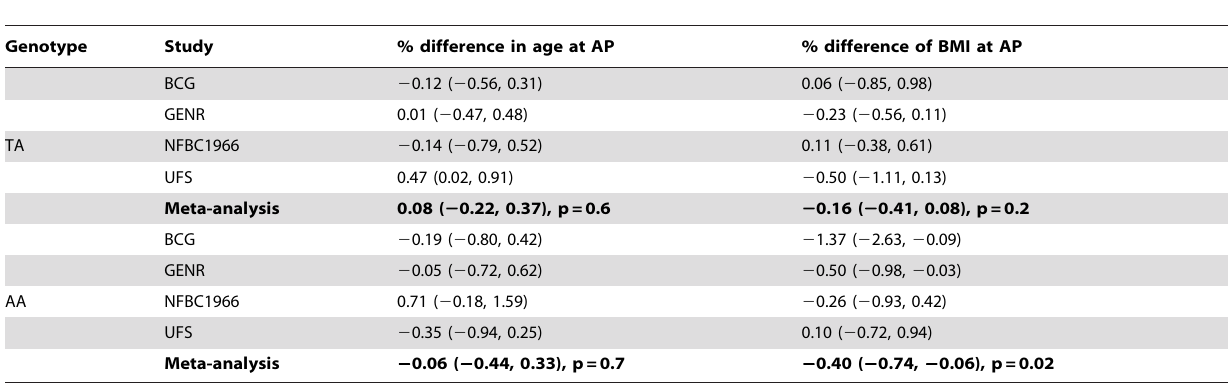
Table 2. Differences in age and body mass index (BMI) at adiposity peak (AP) between FTO genotype groups with 95% confidence interval (95% CI).